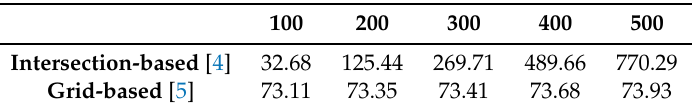
Table 1. The average number of Intersection Points (InPts) and GPs traced by each sensor, under the condition of 100 ∼ 500 deployed